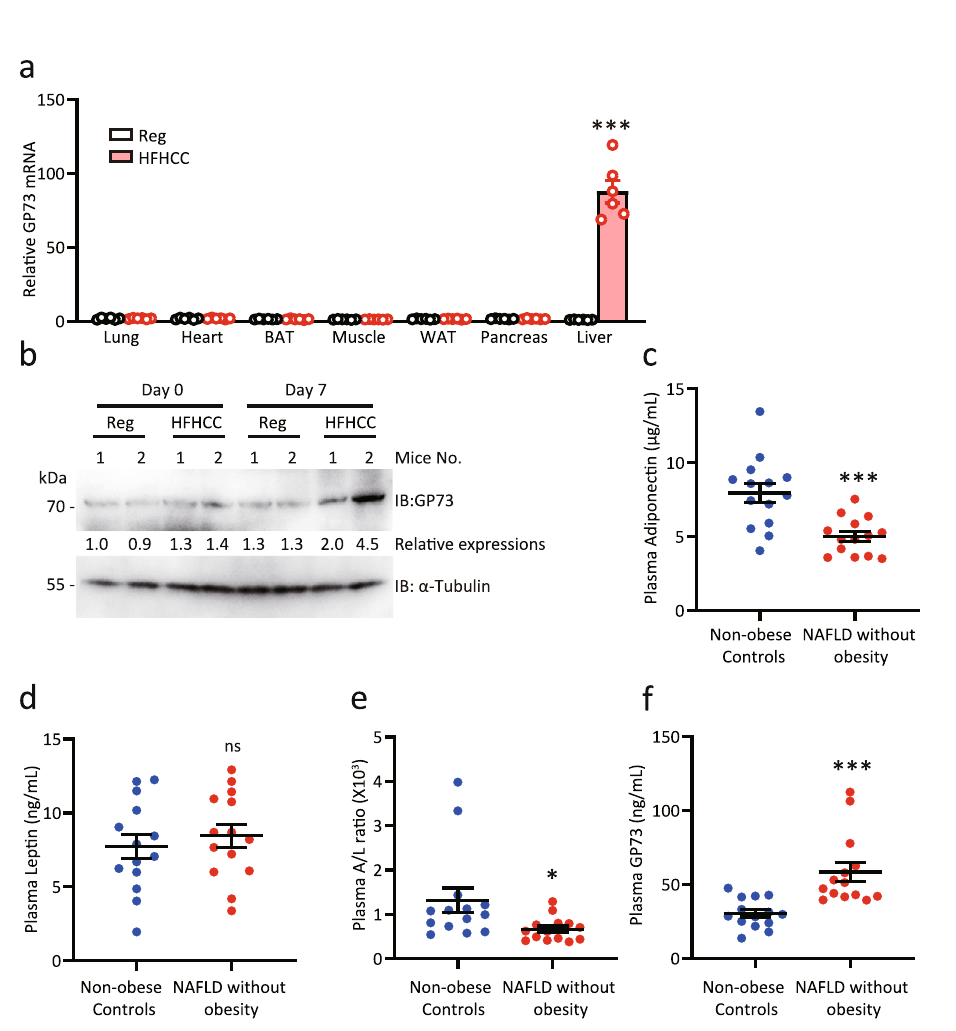
Fig. 7 GP73 expression is pathologically elevated in NAFLD patients without obesity. a GP73 mRNA expression in multiple tissues from mice fed a regular diet (Reg) or a high-cholesterol, high-cholate diet (HFHCC) for 1 month ( n = 6 per group). Differences between the two groups were evaluated using two-sided unpaired Student ’ s t -test. Data are presented as mean ± SEM. *** P < 0.001. b GP73 protein levels in the livers from mice fed HFHCC for 7 days ( n = 2 per group). α -Tubulin was used as the equal loading control. Relative expression was calculated as the fold change in expression relative to the expression in No. 1 control mice. c – f Plasma adiponectin ( c ), leptin ( d ), and adiponectin-to-leptin ratio (A/L ratio; e ); GP73 levels ( f ) in NAFLD patients without obesity and non-obese healthy subjects ( n = 14 per group). Differences between the two groups were evaluated using the two-sided unpaired Student ’ s t -test. Data are presented as mean ± SEM. ns, no statistical signi fi cance; * P < 0.05; *** P <